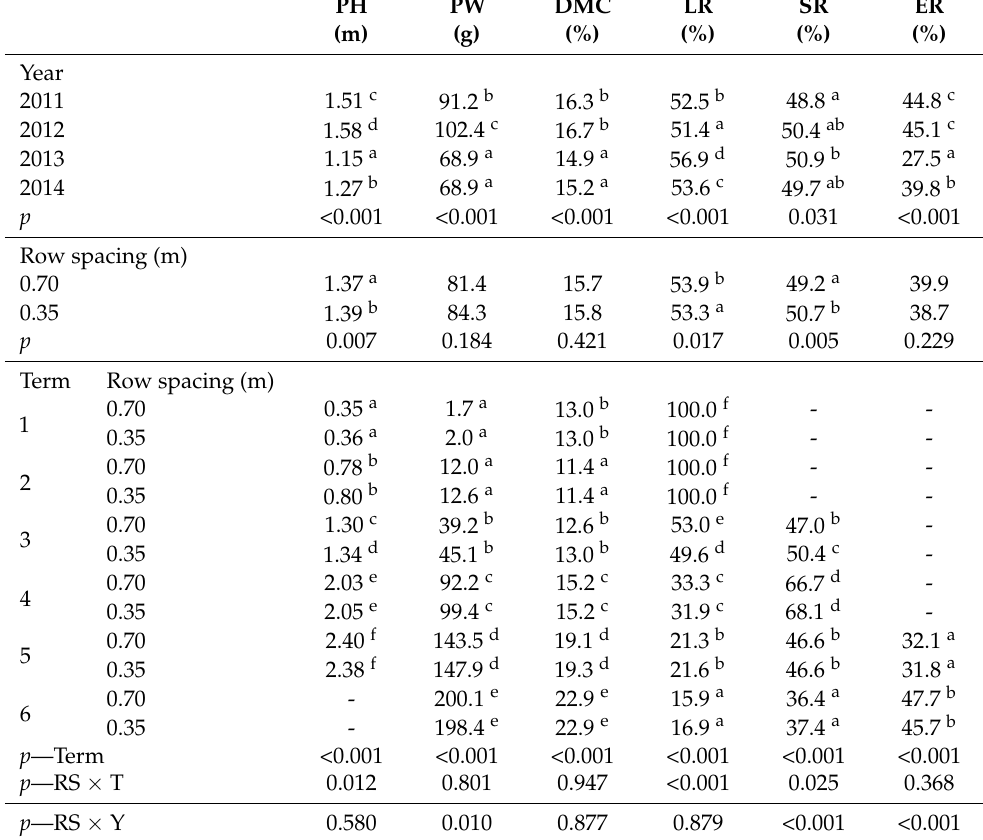
p = probability; different letters indicate statistical differences based on Tukey’s HSD test ( α = 0.05) for each factor separately (year, row spacing or interaction of row spacing × term) within each column. The plant part ratios follow the presence of the plant parts in particular